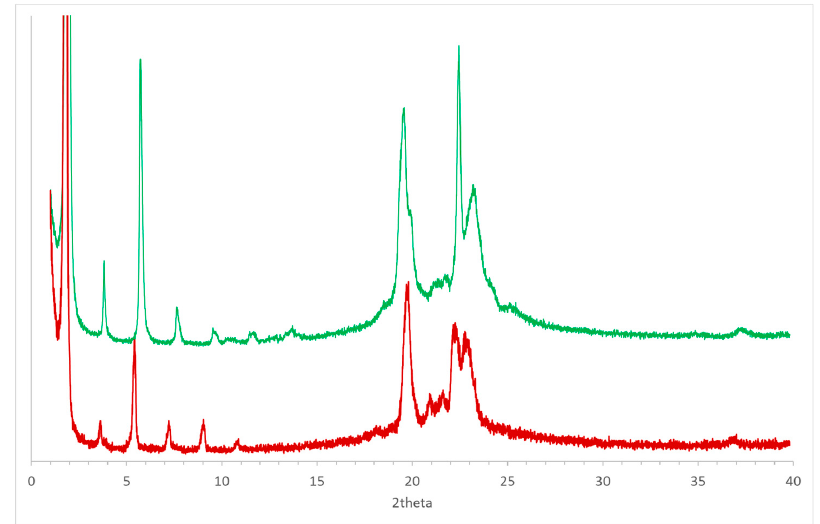
Figure 10. Comparison between the powder diffraction patterns obtained for ( R )-10-HSA (green line) and ( R )-9-HSA (red line) [18] after thermal treatment.